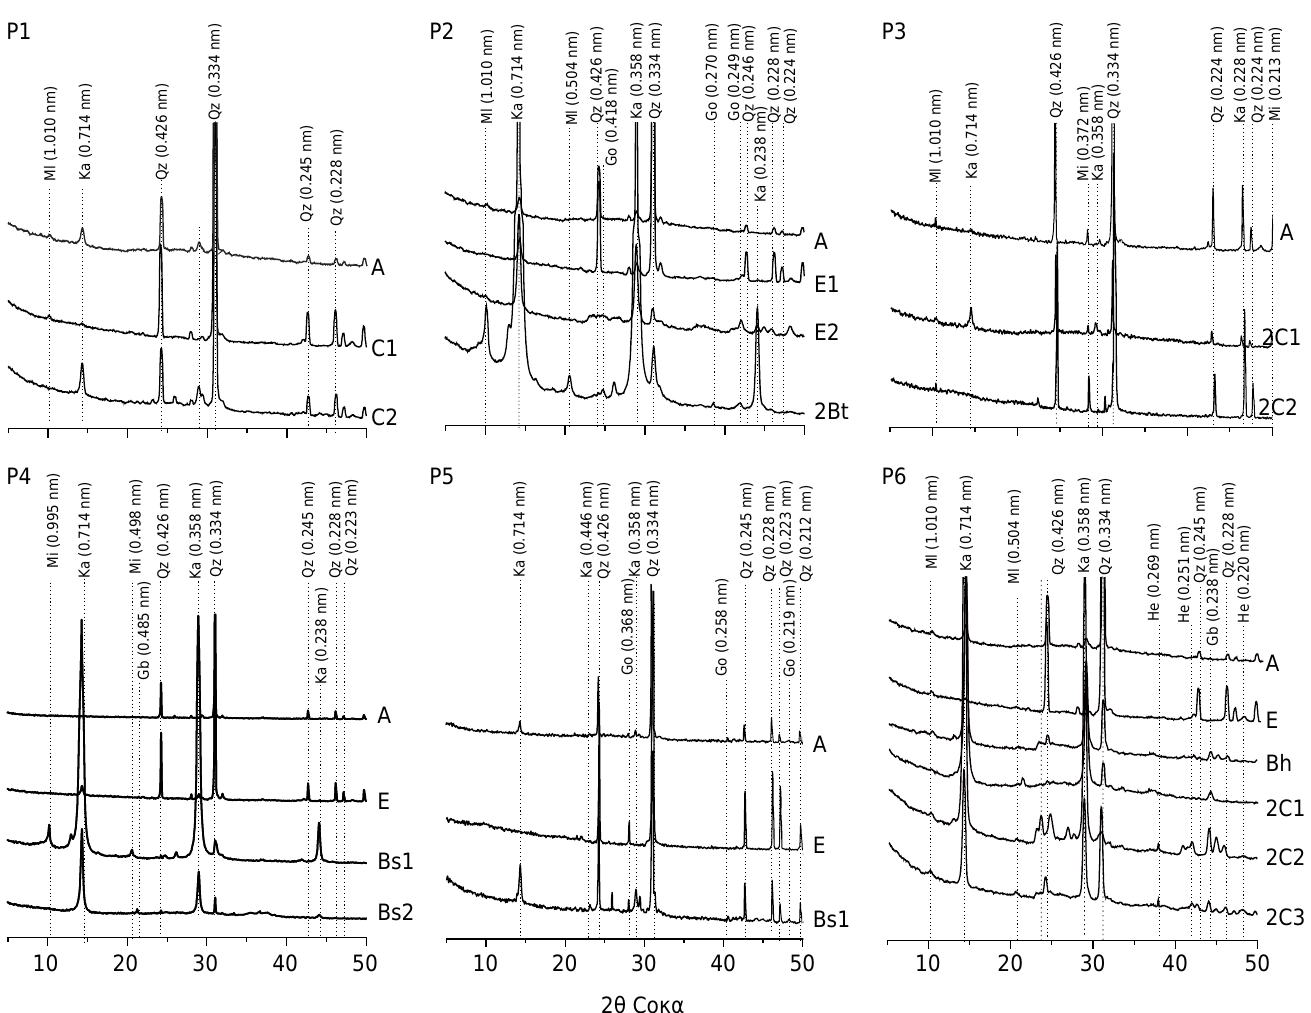
Figure 5. X-ray patterns from clay fraction (powder method) in the horizons of soil profiles. P1…P5: soil profiles. Minerals: Gb: gibbsite; Go: goethite; He: hematite; Ka: kaolinite; Mi: mica; Qz: quartz. Numbers between parentheses correspond to distance between adjacent planes in nanometers (nm).